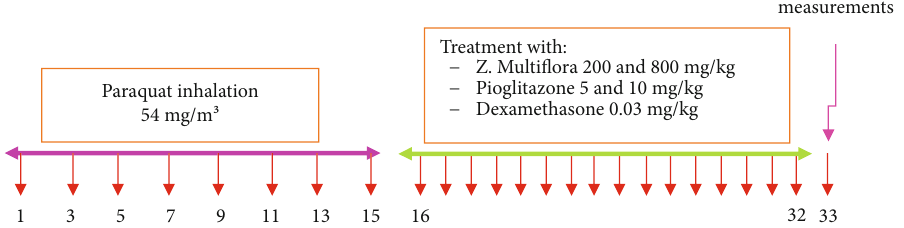
Figure 1: Protocol of exposing animals to t inhaled PQ (54 mg/m 3 ) and treatment of animals with the extract, pioglitazone and